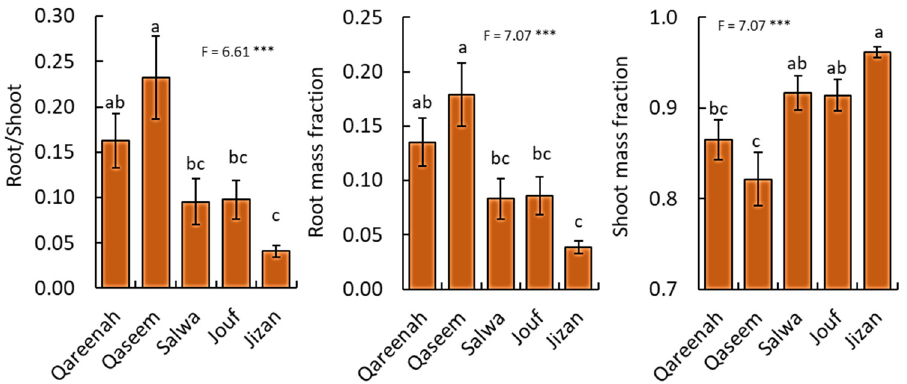
Figure 7. Biomass allocation among Aeluropus lagopoides collected from different saline flat regions of Saudi Arabia, based on dry matter. Values are average ( n = 75 ), and the bar represents the standard error. Different letters among regions showed significant differences at p < 0.05 after Duncan’s test. *** p < 0.05.